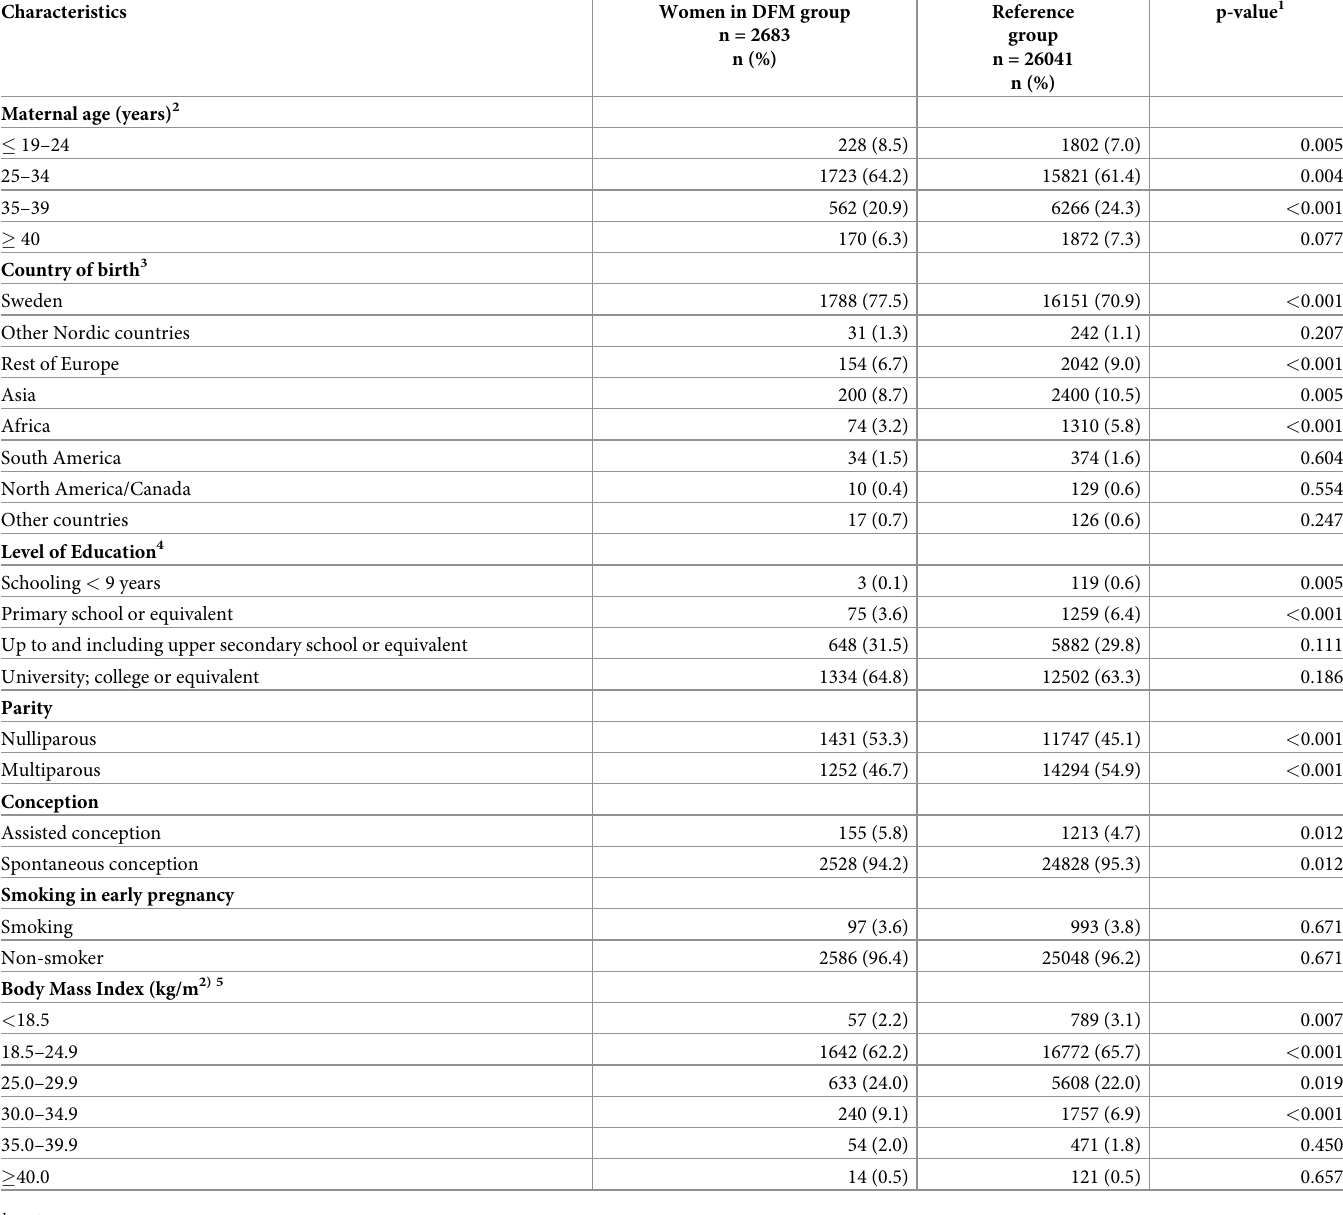
Table 1. Characteristics for women who sought care due to decreased or altered fetal movements (DFM group) and women who gave birth in 2014 (Reference group).